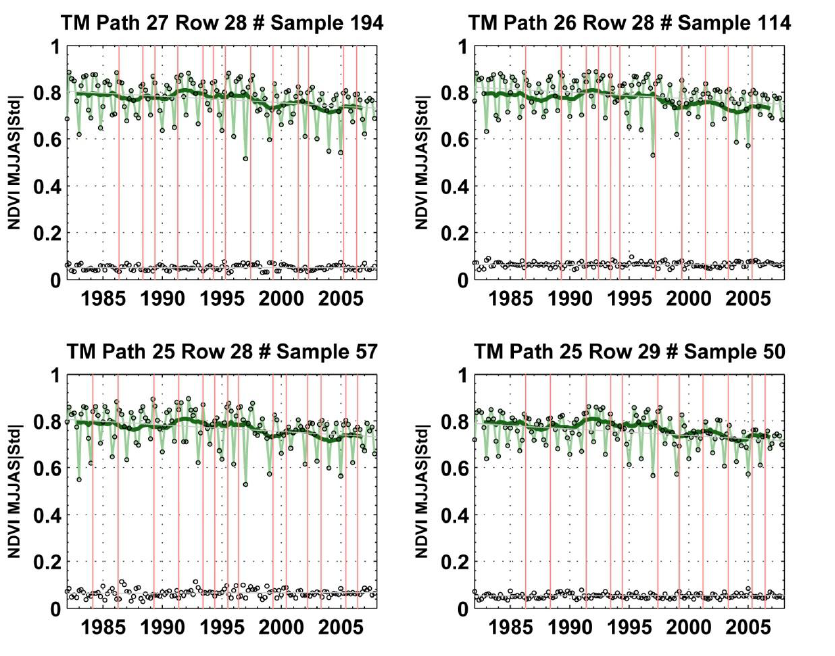
Figure 6. The growing season, May to September, negative GIMMS AVHRR NDVI g trend (the bold green line is the three-year running average) from a sample of pixels (indicated in the plot title) in WRS path/row locations with Landsat dates used in the classification (red vertical lines). The standard deviation for the sampled pixels is shown at the bottom of each plot with black